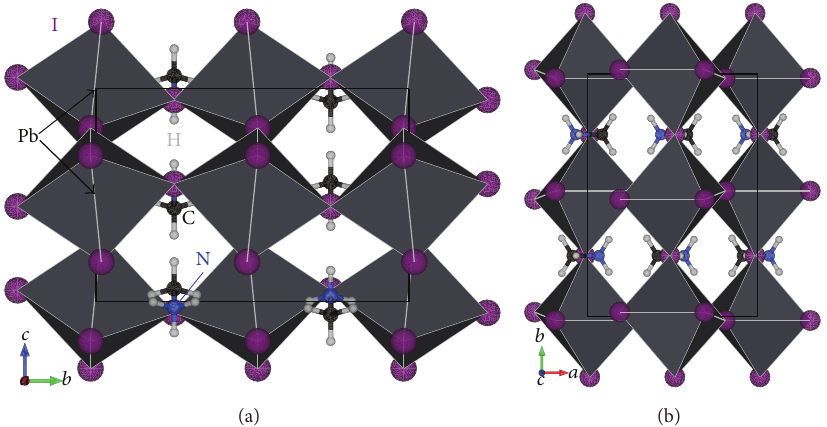
Figure 1: (a) Overview of the low-temperature crystal structure of CH 3 NH 3 PbI 3 projected into the (b,c) plane. Atom labels are given. (b) Overview of the low-temperature crystal structure of CH 3 NH 3 PbI 3 projected into the (a,b)